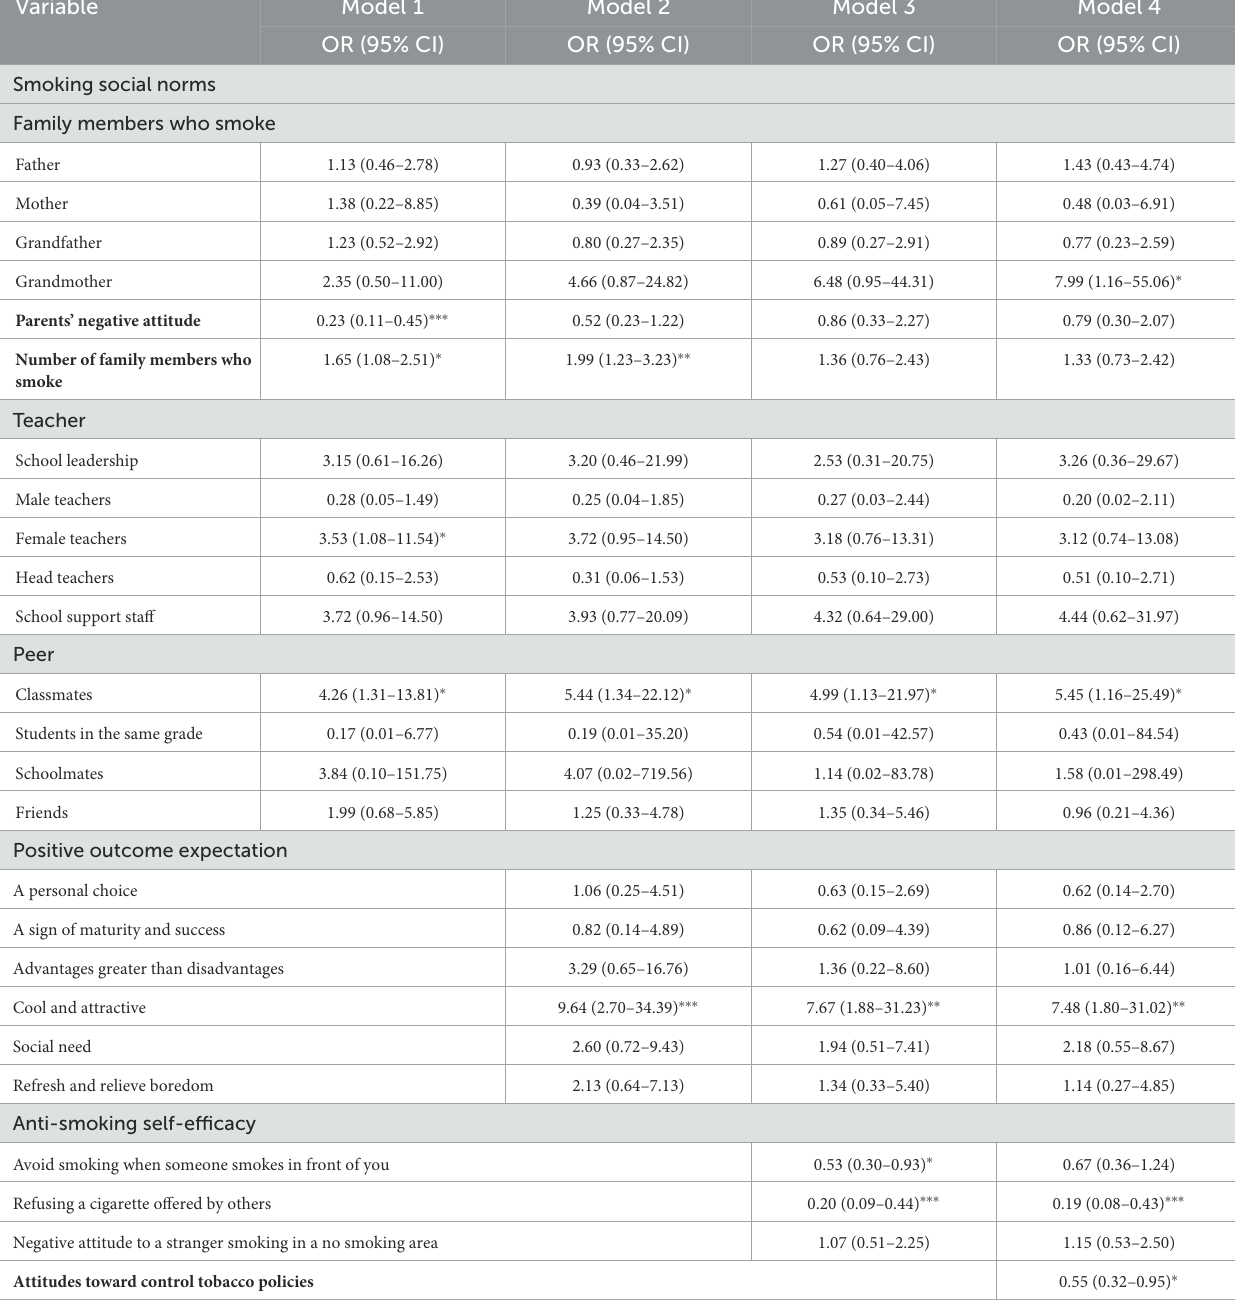
analyses of influencing factors of adolescents’ smoking behaviors (current smoking vs. non-smoking). In Model 1, we analyzed the associations between social norms and adolescents’